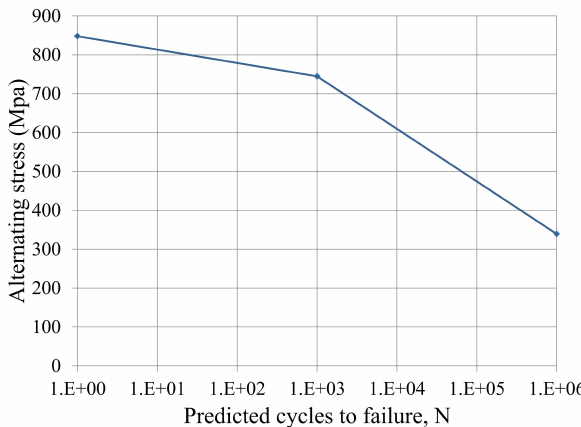
Figure 3. Estimated S–N curve for EBM produced Ti6Al4V.